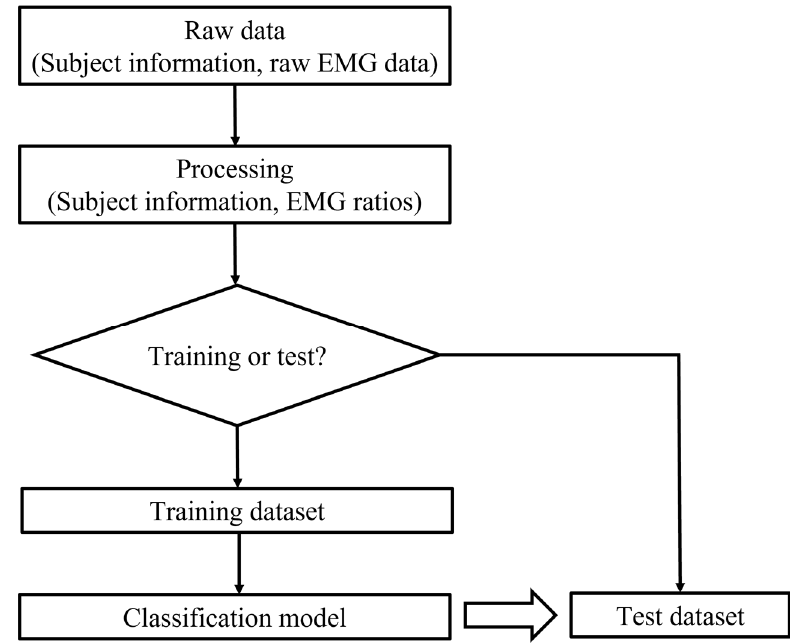
Figure 5. Flow chart of the classification algorithm .